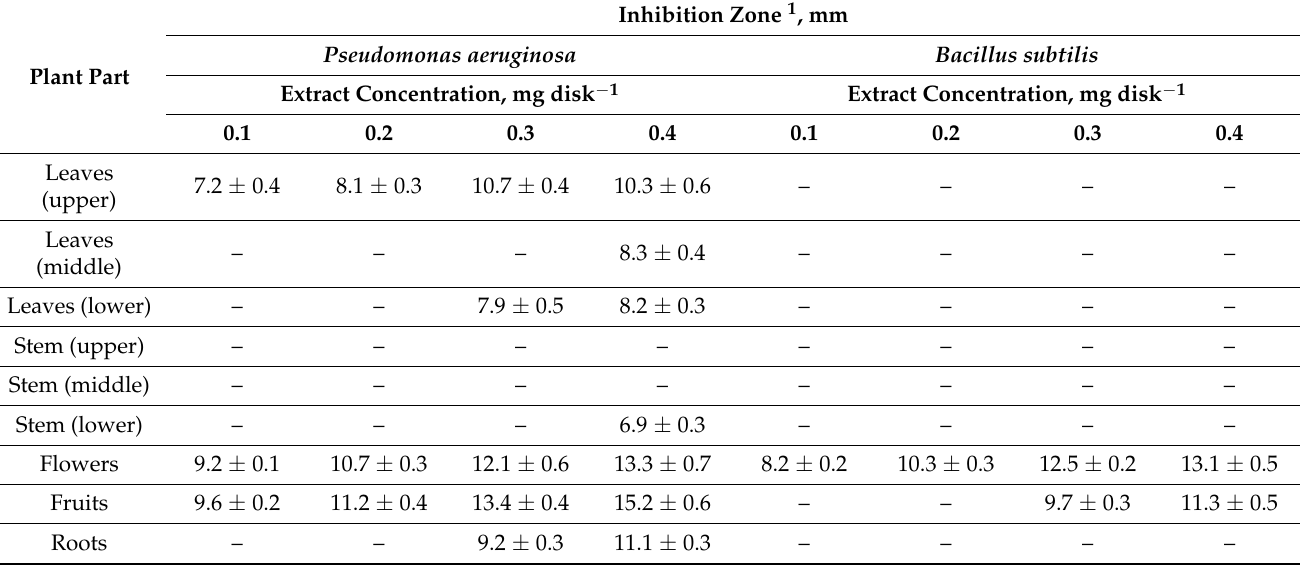
Table 4. Antibacterial activity of meadowsweet extracts (the inhibition zones include the diameter of the disk—6